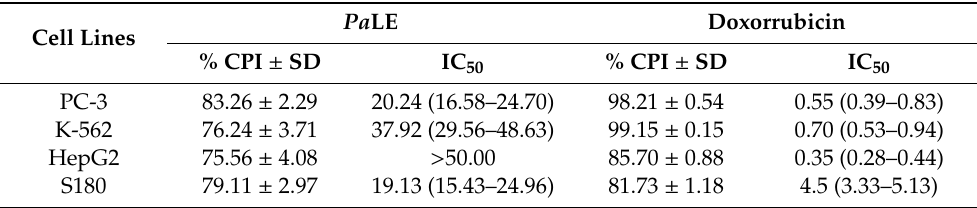
Table 2. Percentage of inhibition of cell proliferation (% CPI) and the average inhibitory